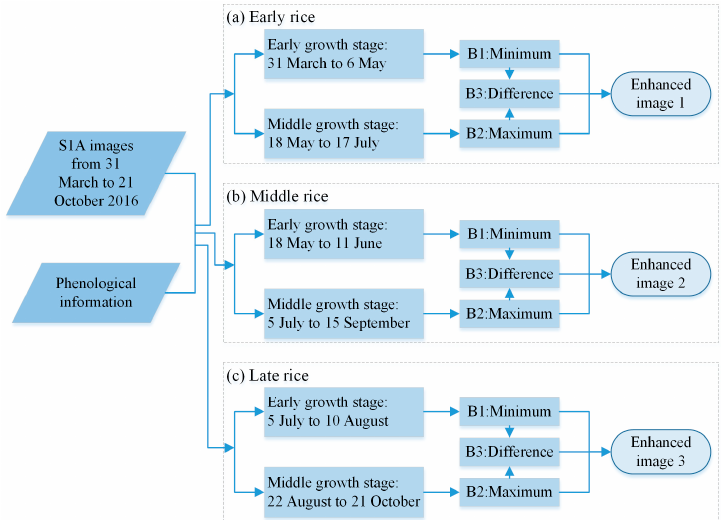
Figure 5. Flow chart of paddy rice image enhancement. “B1: Minimum” was the first band of enhanced image. For each pixel of the first band, its value was the minimum of the image set on paddy rice early growth stage for different types of paddy rice, then all the pixels constituted into the first band. “B2: Maximum” was the second band of enhanced image. For each pixel of the second band, its value was the maximum of the image set on paddy rice middle growth stage for different types of paddy rice. “B3: Difference” was the third band of enhanced image, which was the difference between the first band and the second band.